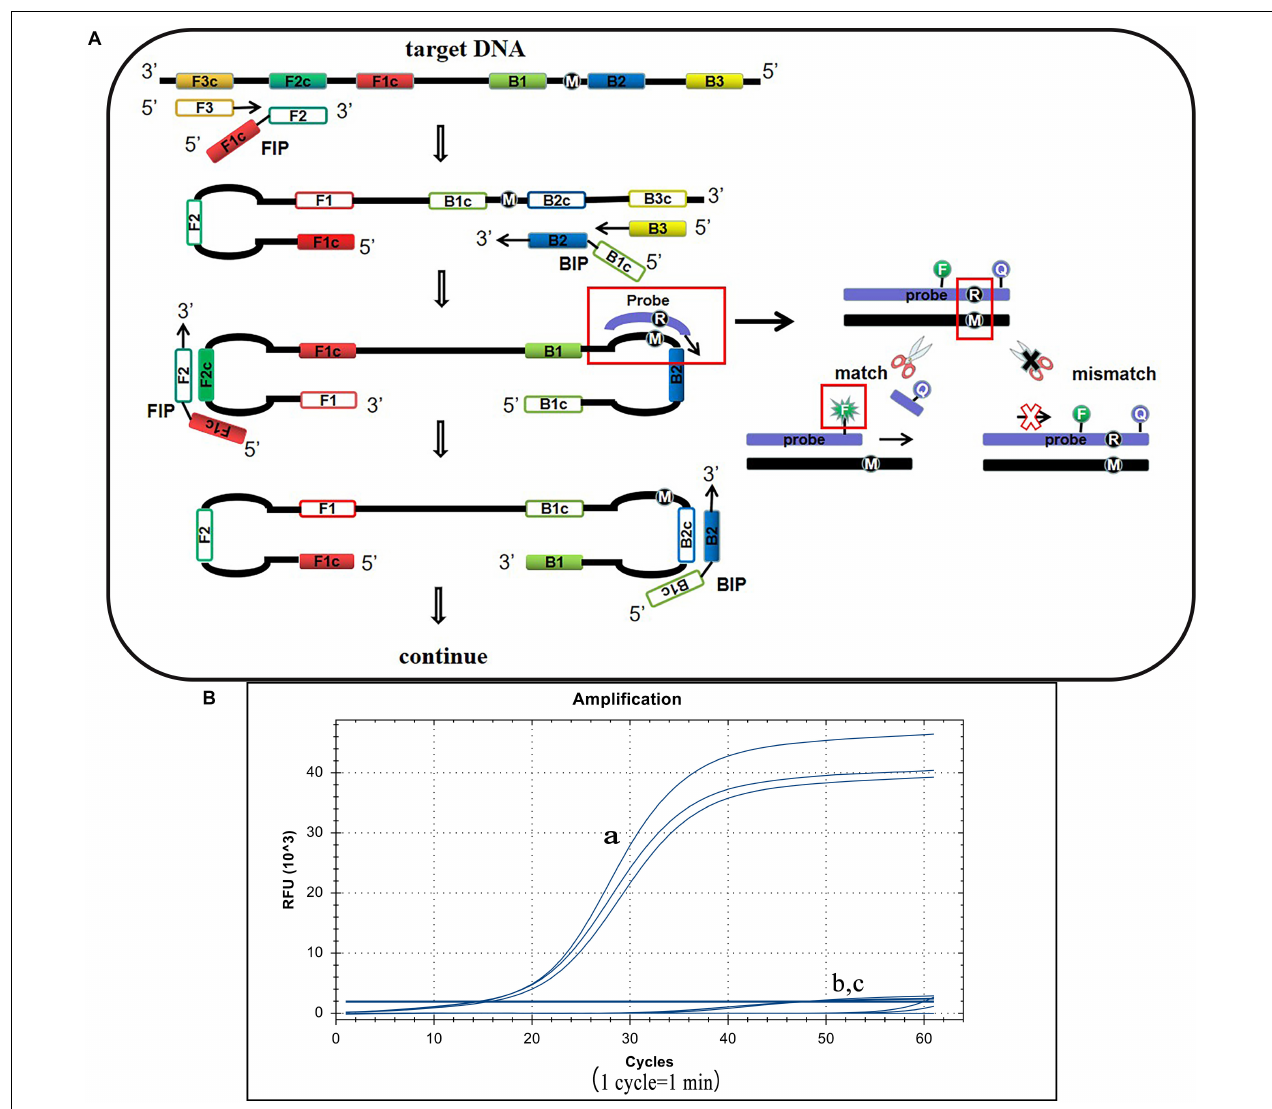
FIGURE 2 | Principle of the LP-LAMP method and the basic reaction system. (A) The principle of the novel SNP detection method (LP-LAMP) established in this study. (B) Basic reaction system. (a) Salmonella Pullorum standard plasmid. (b) Salmonella Gallinarum standard plasmid. (c) Negative